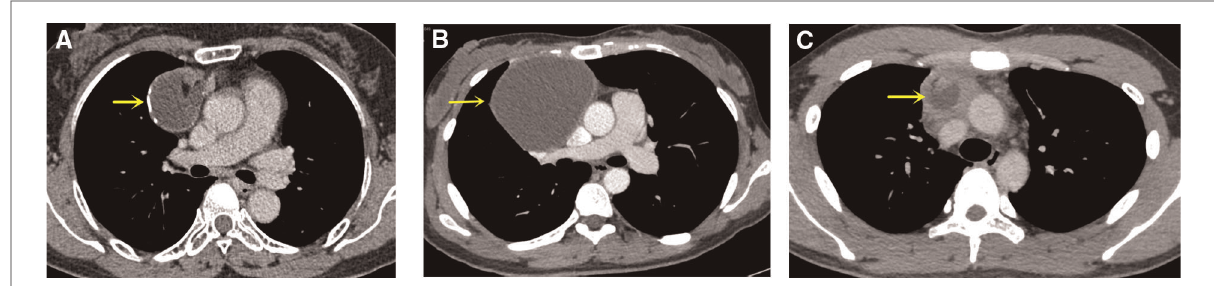
FIGURE 2 Mediastinal mature teratomas on the CT image. ( A ) Separation is de fi ned as a well-de fi ned lesion, at a certain distance from the surrounding blood vessels (SVC and IV); ( B ) Proximation is de fi ned as a clear boundary between the lesion and surrounding organs, and the blood vessel is partially deformed by the mass; ( C ) Invasion is de fi ned as the non-fatty lesion invaded the surrounding vessels. The yellow arrow points to MMT. CT, computerized tomography; SVC, superior vena cava; IV, innominate vein; MMT, mediastinal mature